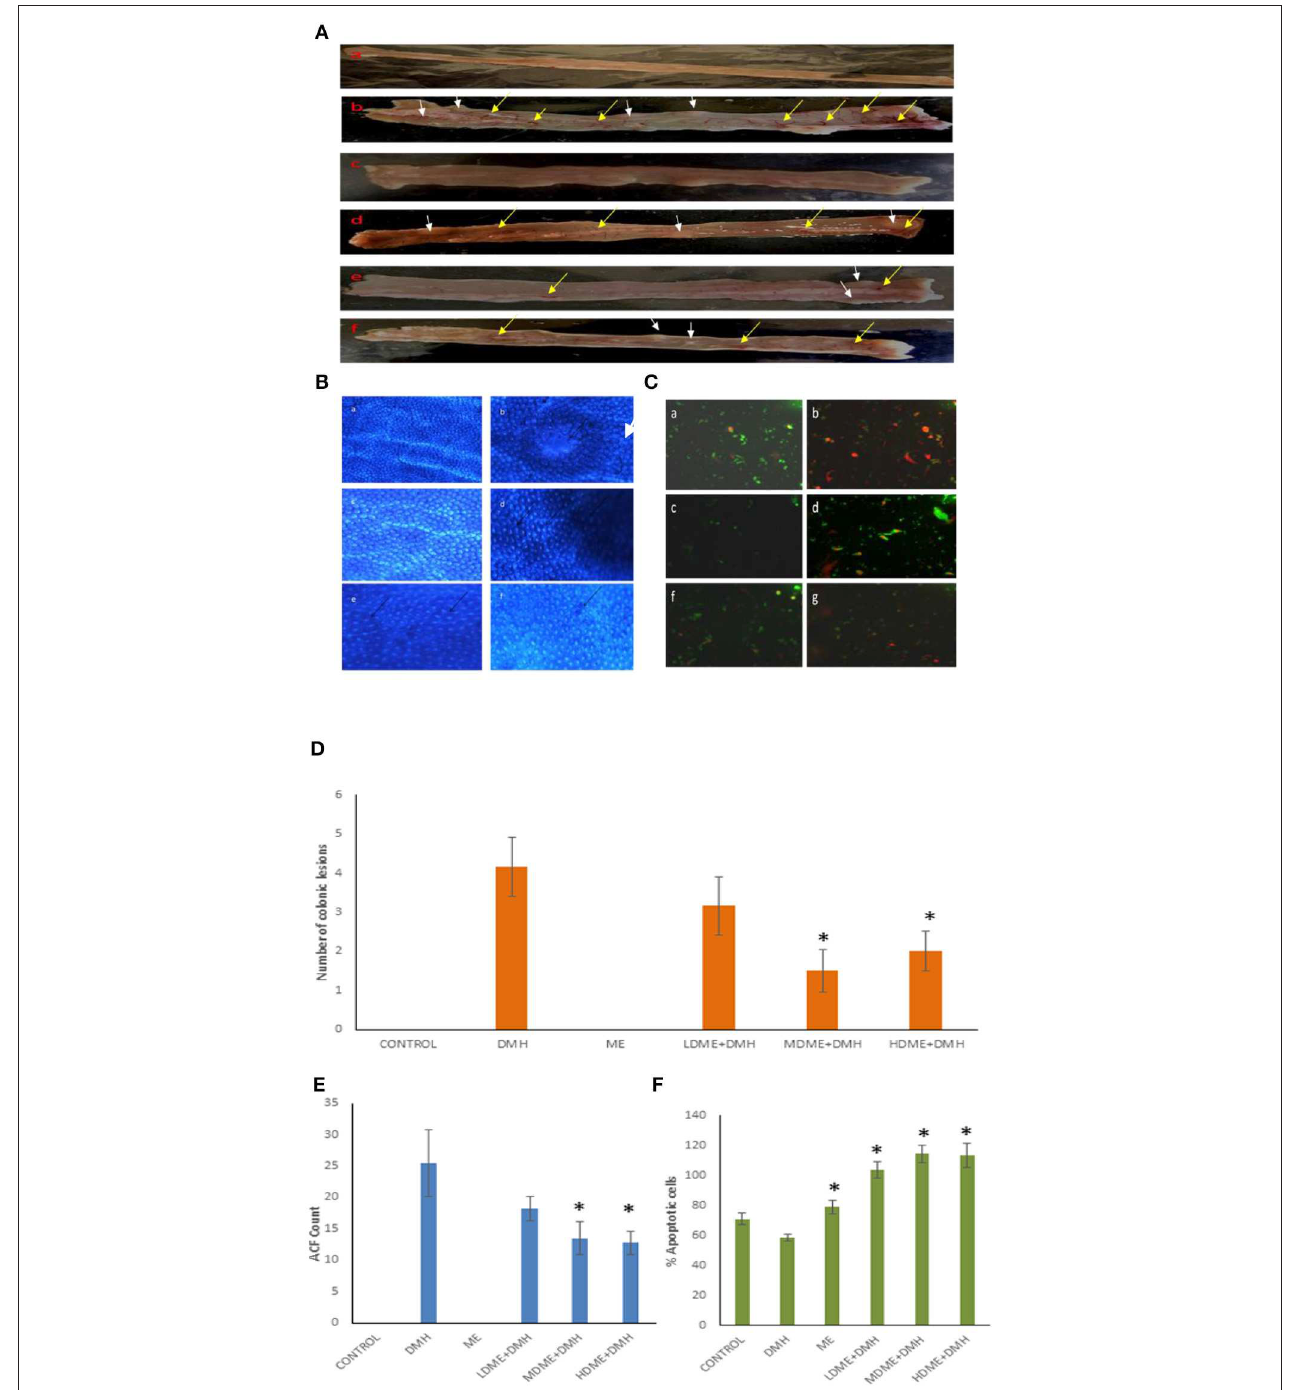
FIGURE 4 | (A) Macroscopic observation of inflammation (yellow arrows) and lesions (white arrows). (B) Topographic view of the colon stained with methylene blue showing: (a) normal crypts, (b) flat mucin depleted aberrant crypt foci (arrow), (c) almost normal crypts, (d) numerous aberrant crypts (arrows), and (e, f) fewer aberrant crypts. (C) Ethidium bromide/acridine orange stained colonocytes of animals belonging to different groups: (a) control, (b) 1,2-dimethylhydrazine (DMH)-treated, (c) metabiotic extract (ME), (d) LDME + DMH, (e) MDME + DMH, (f) HDME + DMH (400 × ). Quantification of (D) number of colonic lesions. (E) Aberrant crypt foci (ACF) count. (F) Percent apoptotic cells in various groups of